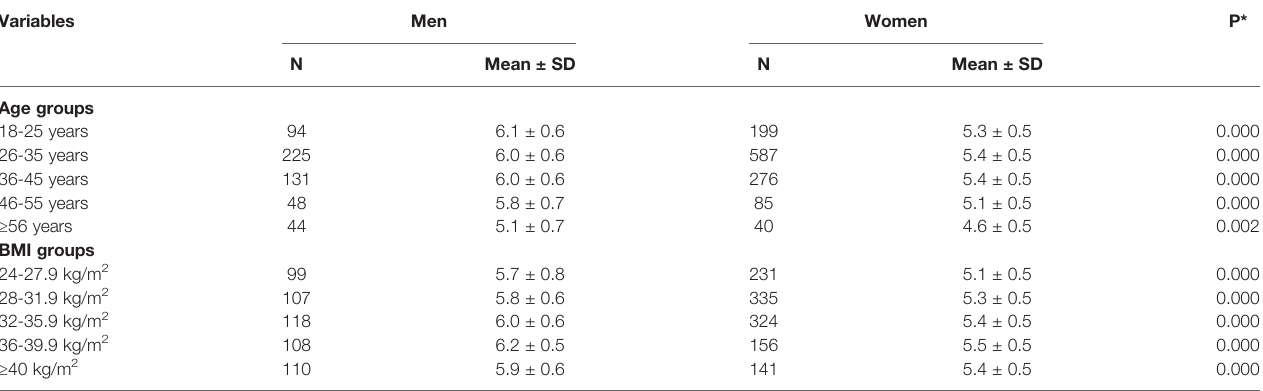
TABLE 4 | 50kHz-phase angle for Chinese in difference age and BMI groups by